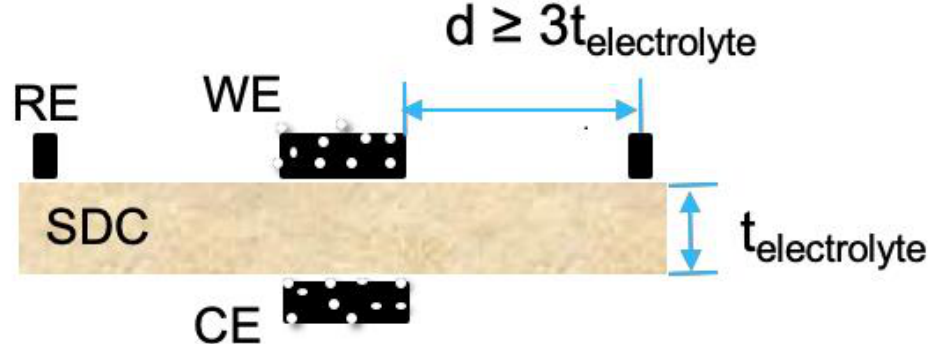
Scheme 1. Pictorial description of the three-electrode set up used for the electrochemical impedance